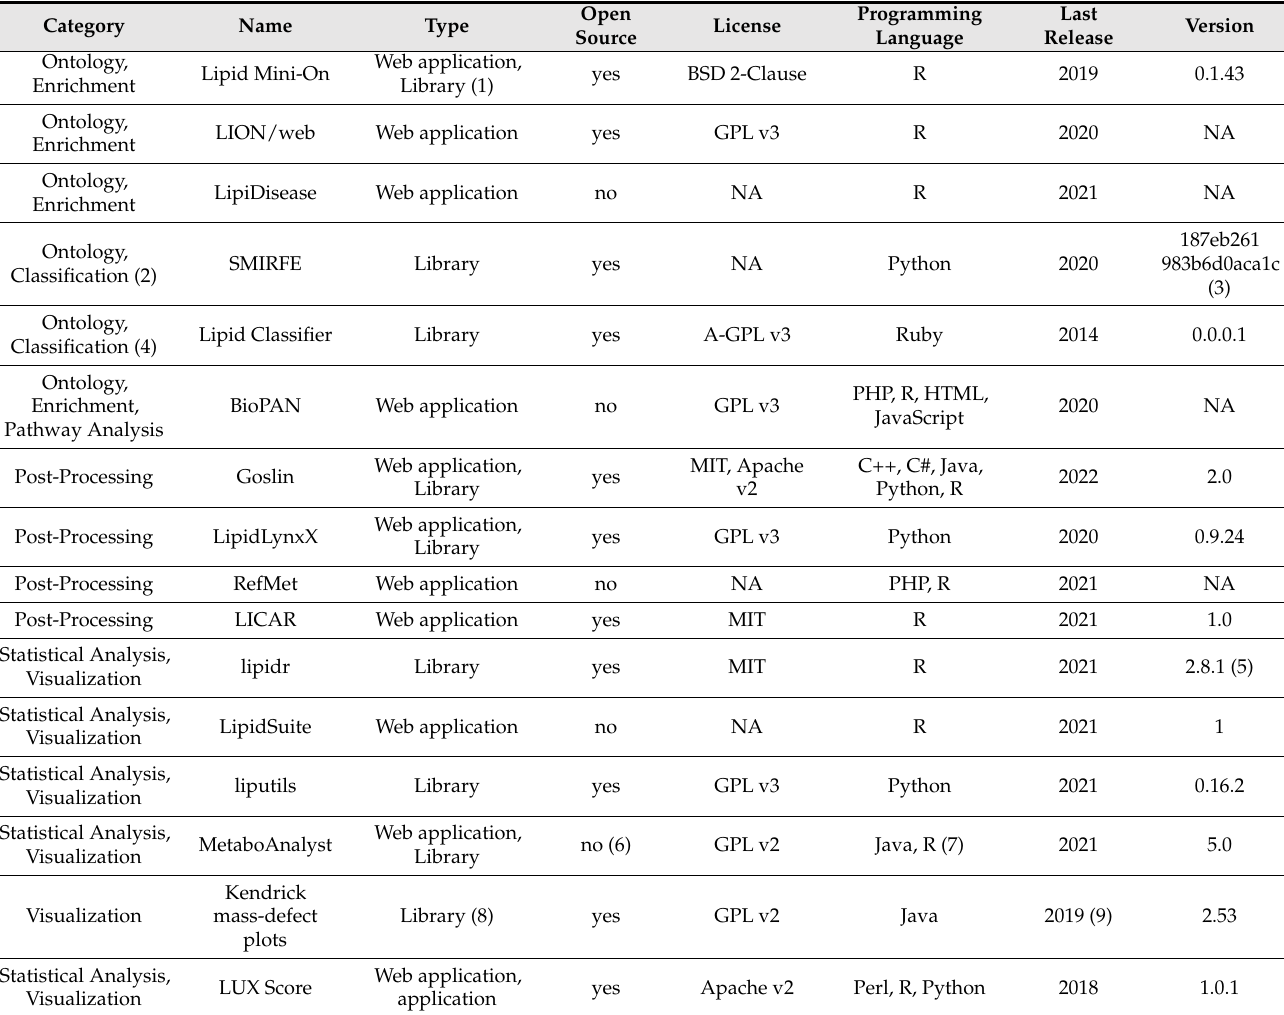
Table 2. Libraries and web applications for Pathway analysis, ontology mapping/classification, enrichment analysis, post-processing, visualization and statistical analysis. Remarks: (1) Library Rodin is used by the web application. (2) From molecular formulas. (3) Figshare id. (4) Based on lipid structural features. (5) Part of Bioconductor release 3.14. (6) Only the R package is open-source. (7)